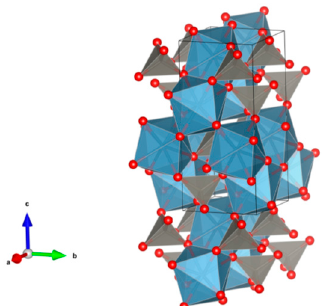
18 of 49 Figure 29. Thorium phosphate/Diphosphate (TPD). Th 4 (PO 4 ) 4 P 2 O 7 . Structure orthorhombic. Sp. gr. Pbcm and Pcam. Cations can be U, Np, Pu, Am and Cm. 4.5. Tungstate, Molybdates 30. Scheelite [89,440–457], Figure 30.